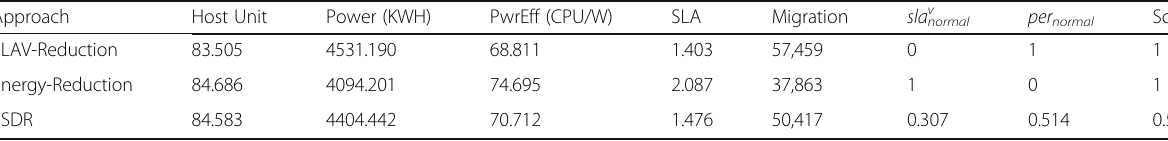
Table 6 The results of 5 workload patterns for each approach